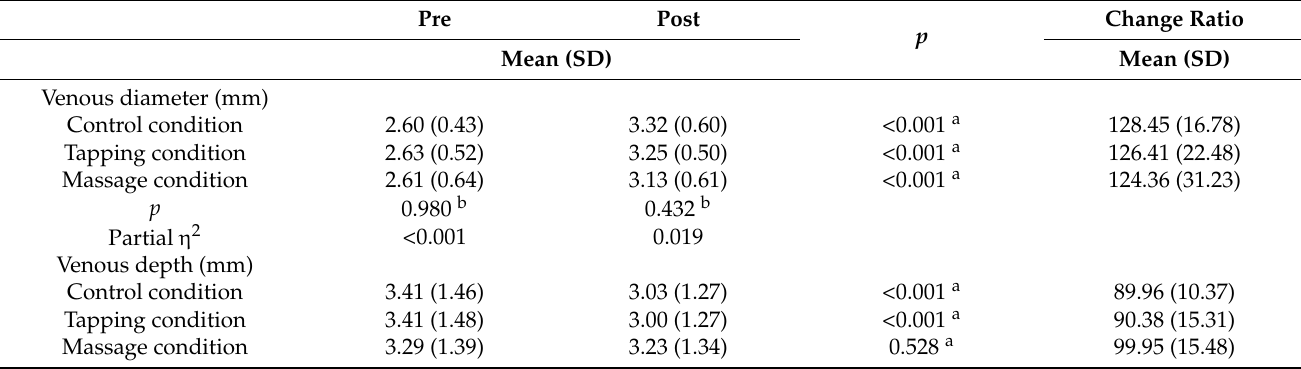
Table 2. Change in venous diameter and depth (n =